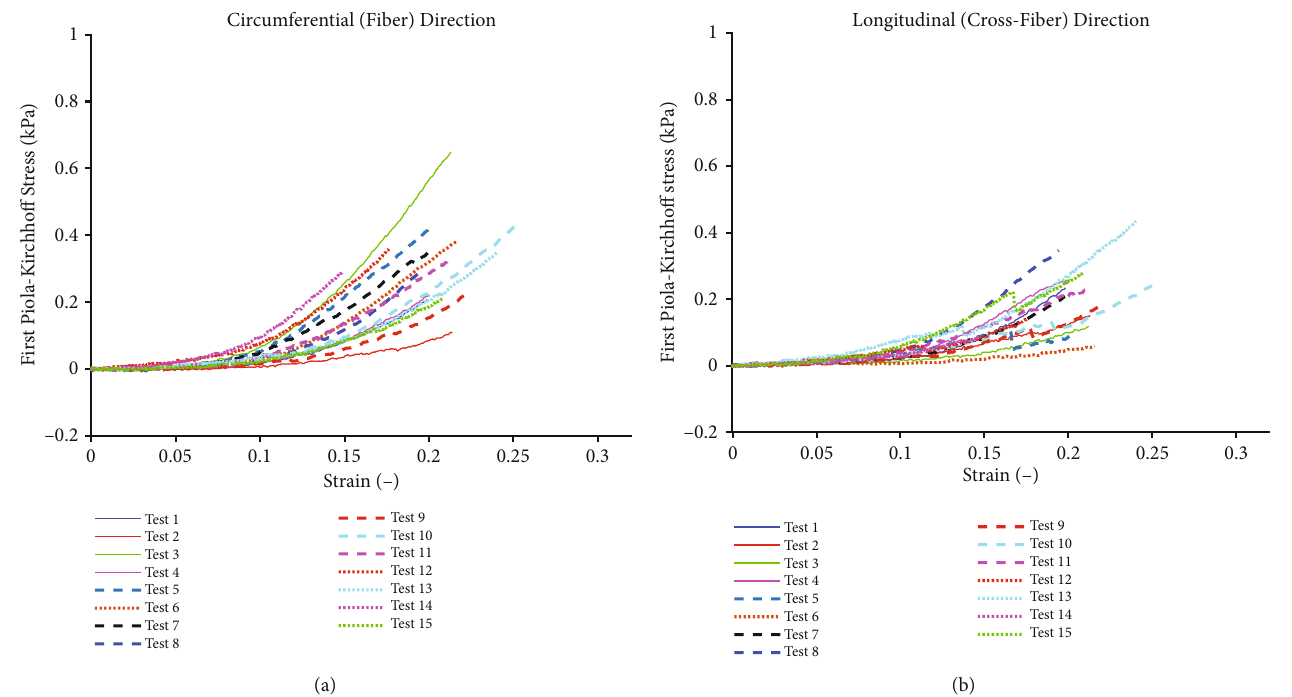
Figure 3: Porcine sclera soft tissue ( N = 18 ) subjected to equi-biaxial mechanical forces showing stress (kPa) vs. strain mechanical properties up to 25% strain (a) circumferential and (b) longitudinal. Test 3 and test 4 are showing the lowest and highest tress in the circumferential direction, respectively. Additionally, test 1 is showing the highest stress, and test 15 is showing the lowest stress in the longitudinal direction,